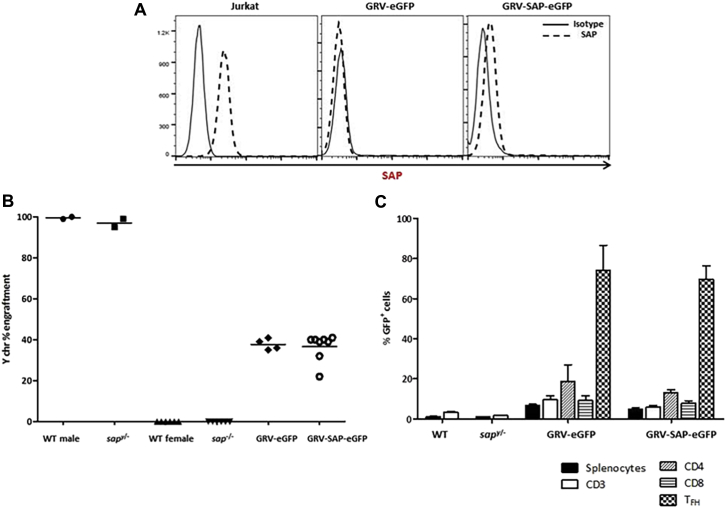
Analysis of adoptively transferred T cells. A, SAP protein expression was analyzed in gene-corrected murine splenic CD3+ T cells after reconstitution. B, Donor T-cell engraftment was assessed in whole splenocytes by using XY PCR techniques 10 weeks after reconstitution, showing average engraftment levels of 40%. C, Analysis of GFP levels in whole splenocytes and splenocyte-derived T-cell lineages in immunized animals.